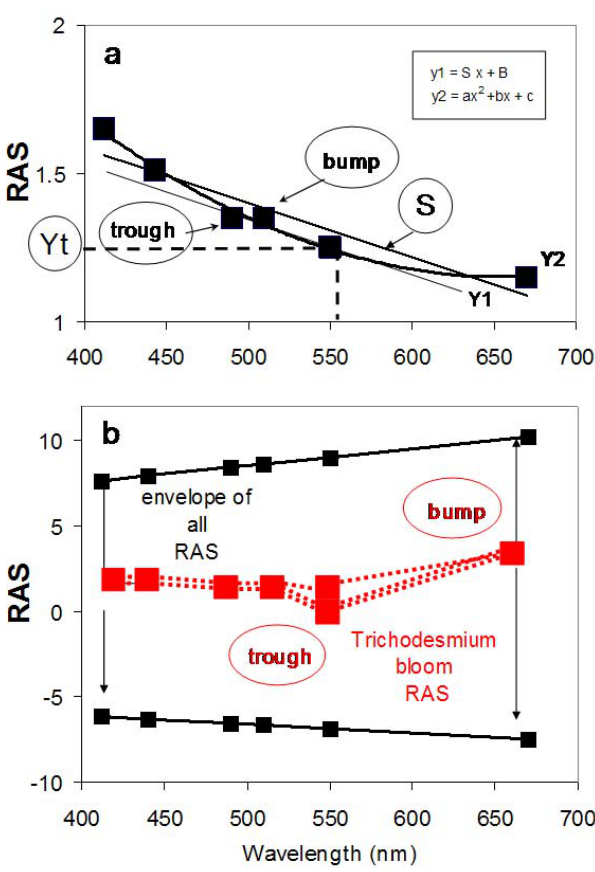
Fig. 3. (a) Descriptive parameters to characterize the radiance anomaly spectra (RAS) relative to K490 for Trichodesmium detec- tion in surface oceanic waters for a SeaWiFS pixel: S = slope of the linear fit; Yt = ordinate of the second degree fit for which tangent is parallel to linear fit; “Bump” and “Trough” are the wavelengths of the major positive and major negative deviations relative to the sec- ond degree polynomial fit (largest “bump” or largest “trough”, re- spectively) (b) Ranges of S and Yt for all RAS of all SeaWiFS pix- els (black). In orange, specific S and Yt and positions of bumps and troughs schematically shown for RAS of a Trichodesmium